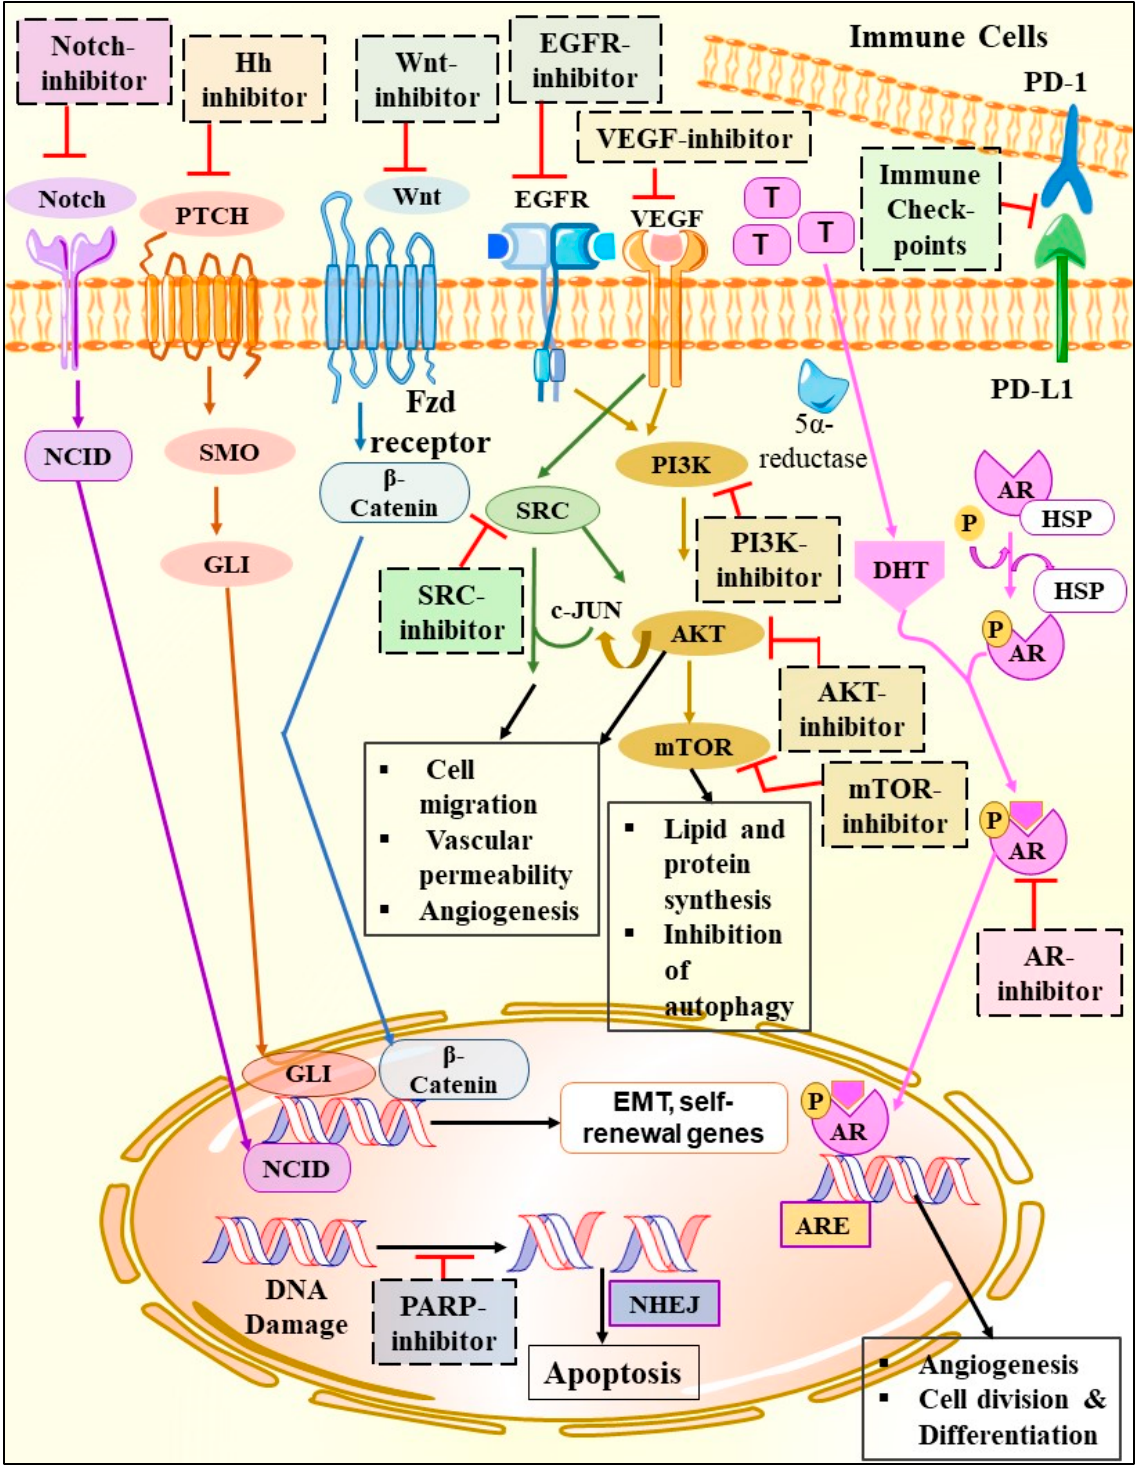
Figure 3. Schematic illustration of the potential targets and potential therapeutic agents, focused on the effective treatment of TNBC: Various signaling pathways have been involved in the etiology of TNBC, which encompasses EGFR, VEGFR, PDGFR, FGFR, Wnt, Notch, Hedgehog, immune check- point receptors, PI3k/AKT/mTOR, RAS, and JAK/STAT. Now, taking into account the intra- and inter heterogeneity, and the prospect of feedback mechanism to promote resistance to therapy, tar- geted inhibition is employed in combination with mitotic inhibitors and DNA damaging agents, which includes inhibitors of CDK4/6, CHK1/2, and PARP1. The red line indicates inhibition, and the black arrow indicates stimulation [51].